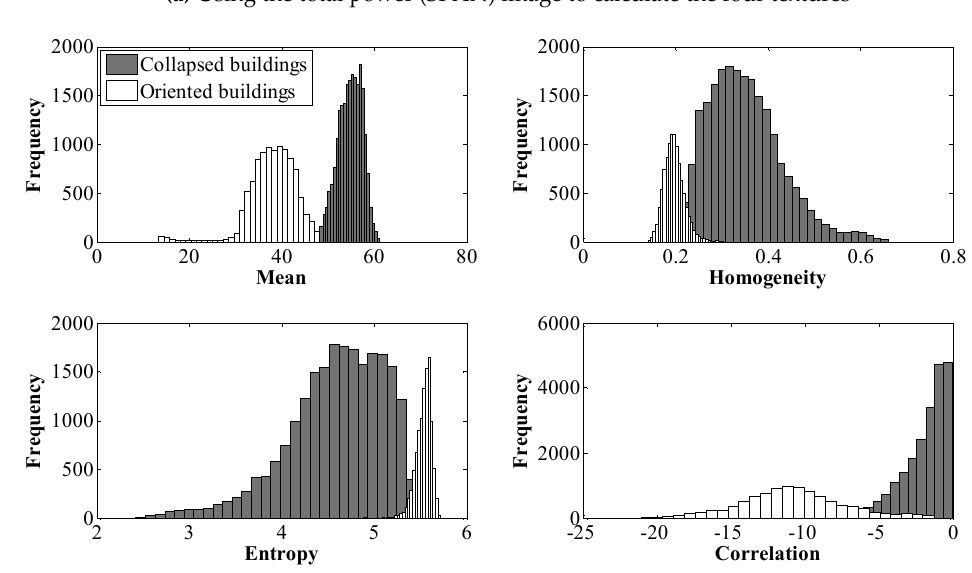
Figure 5. The histogram comparison of the four texture features for the samples of CB and OB.